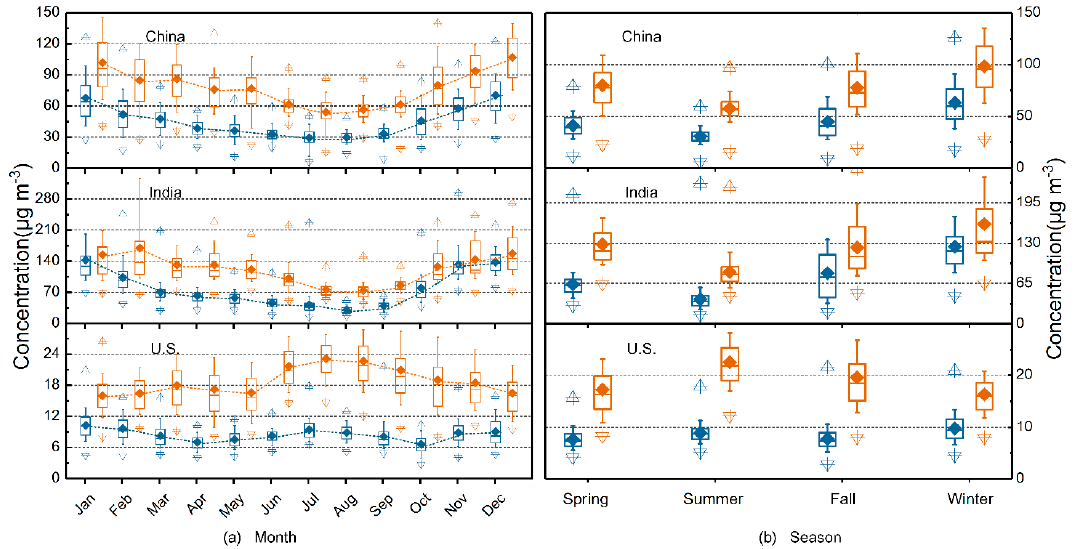
Figure 3. Particulate matter concentrations in China, India, and the U.S. from 2014 to 2017 by ( a ) month and ( b ) season. The blue and yellow box plots show seasonal 90th, 75th, 50th, 25th, and 10th percentiles of PM 2.5 and PM 10 concentrations, respectively; triangles indicate maximum and minimum values and diamonds indicate seasonal averages. Spring is defined as March through May, summer as June through August, fall as September through November, and winter as January, February, and December.